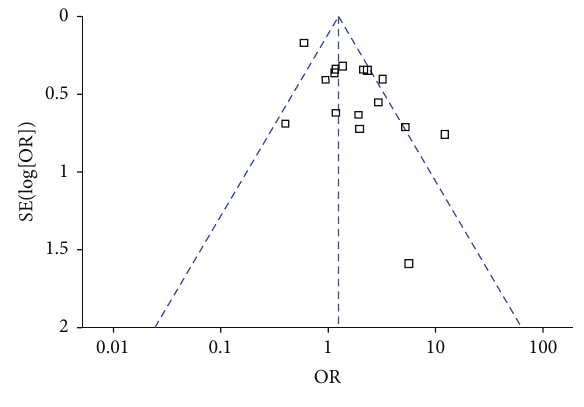
Figure 3: Funnel plot